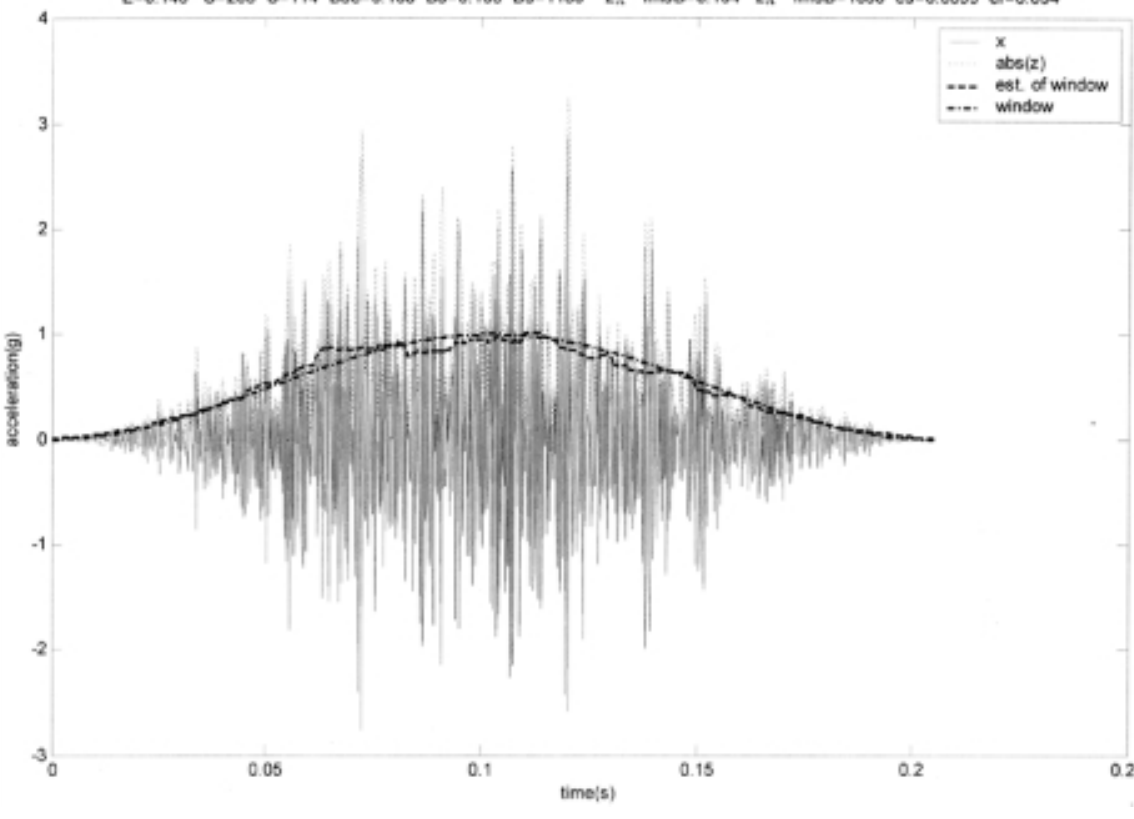
Fig. A1. Example of a nonstationary random